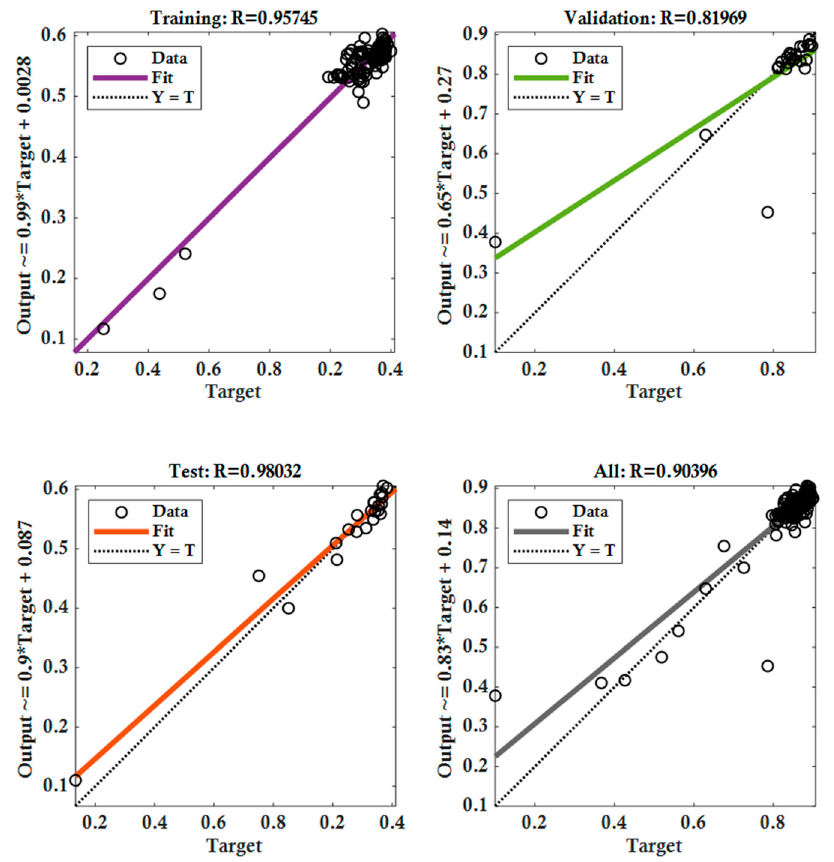
0.83541, and 0.22935, respectively. Figure 8. Maximum squared error (MSE) vs. the number of nods in the hidden layer.